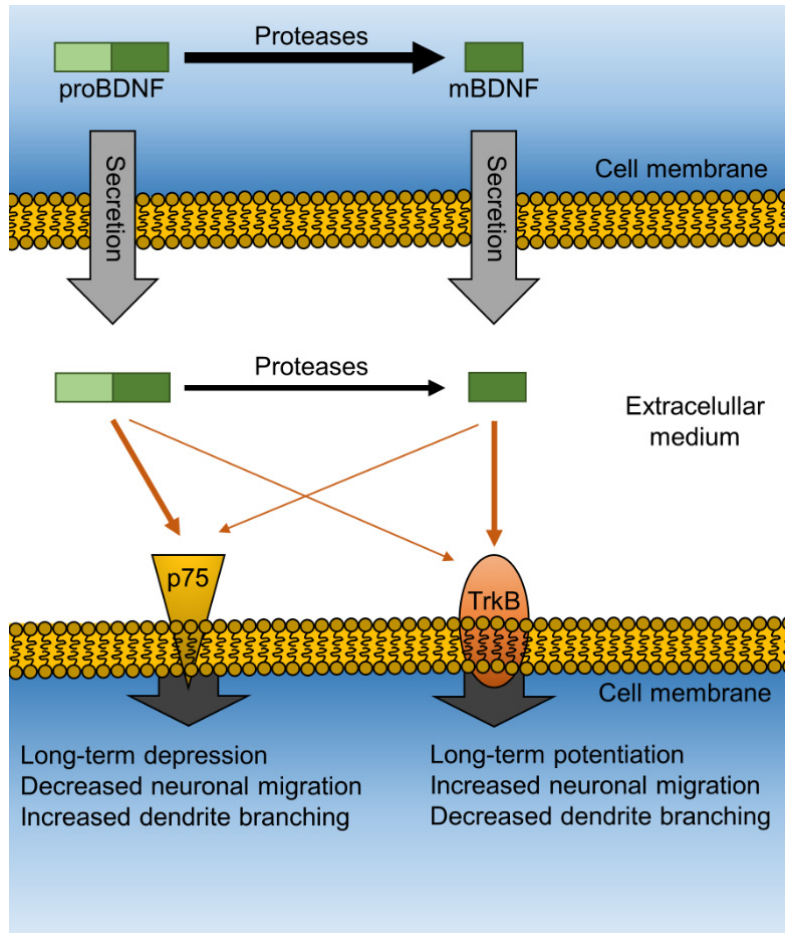
Figure 2. Diagram of the functional role of BDNF isoforms. Conversion of the precursor proBDNF to the mature form mBDNF occurs mainly intracellularly. Both isoforms are secreted and exert their actions on neurotrophin receptor p75 (p75 NTR ) or the tropomyosin receptor kinase B (TrkB). Downstream effects of proBDNF and mBDNF are functionally